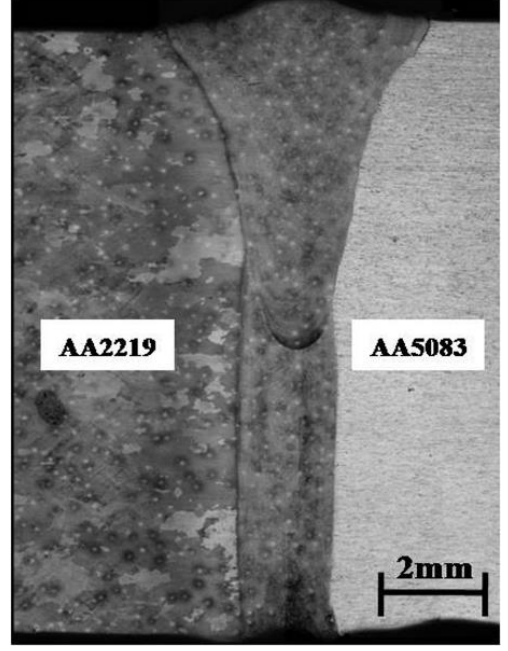
Figure 3. Macrostructure of representative AA 2219-AA 5083 EB weld joint.